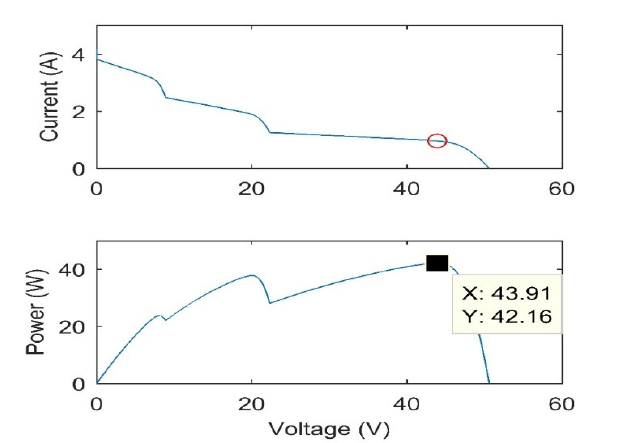
FIG. 10. GLOBAL I-V &P-V CHARACTERISTICS OF PV ARRAY IN STRONG PARTIAL SHADING CONDITION